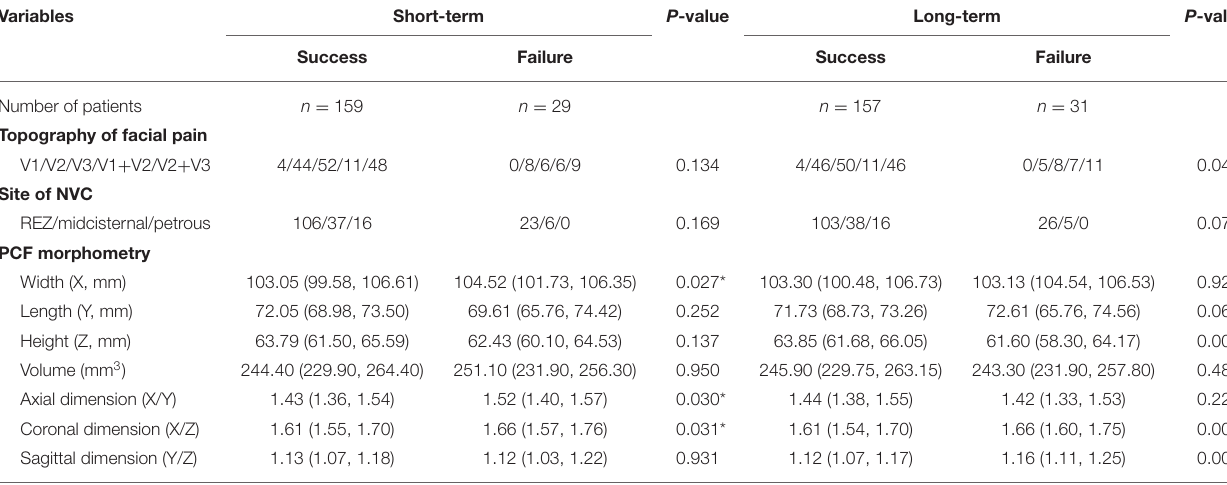
TABLE 4 | Outcomes after MVD for classic TN patients caused by sole arterial NVC.